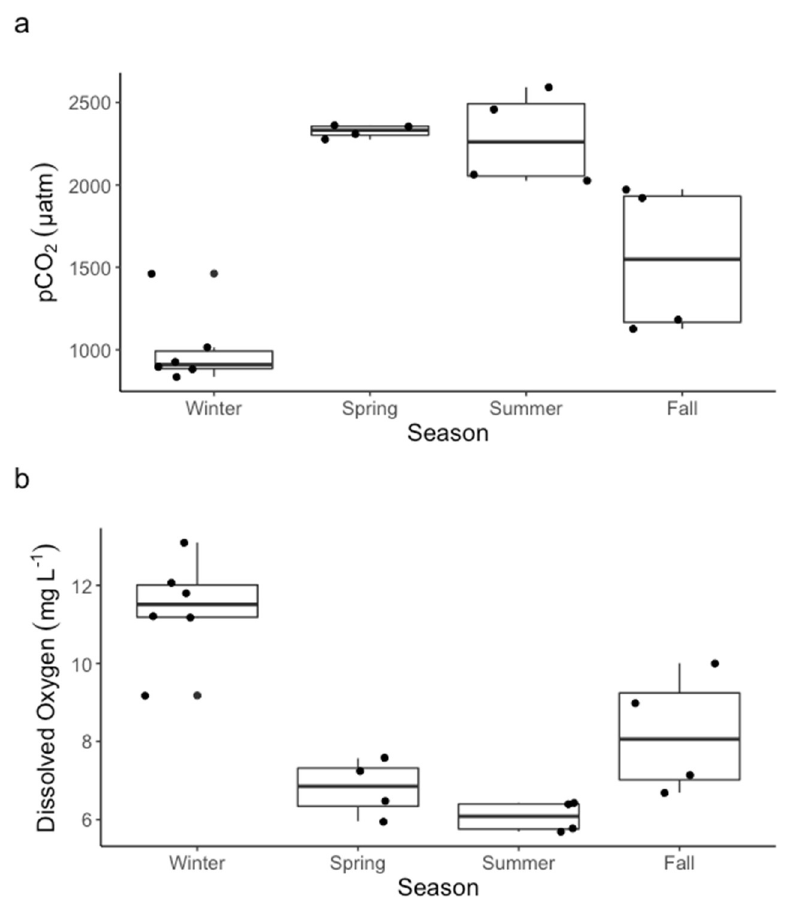
Figure 5. Boxplot of seasonal variation in riverine ( a ) p CO 2 ; ( b ) Dissolved oxygen concentration. Dots showing sample points. Table 3. Total mass export of dissolved inorganic carbon ( DIC) dissolved organic carbon (DOC), CO